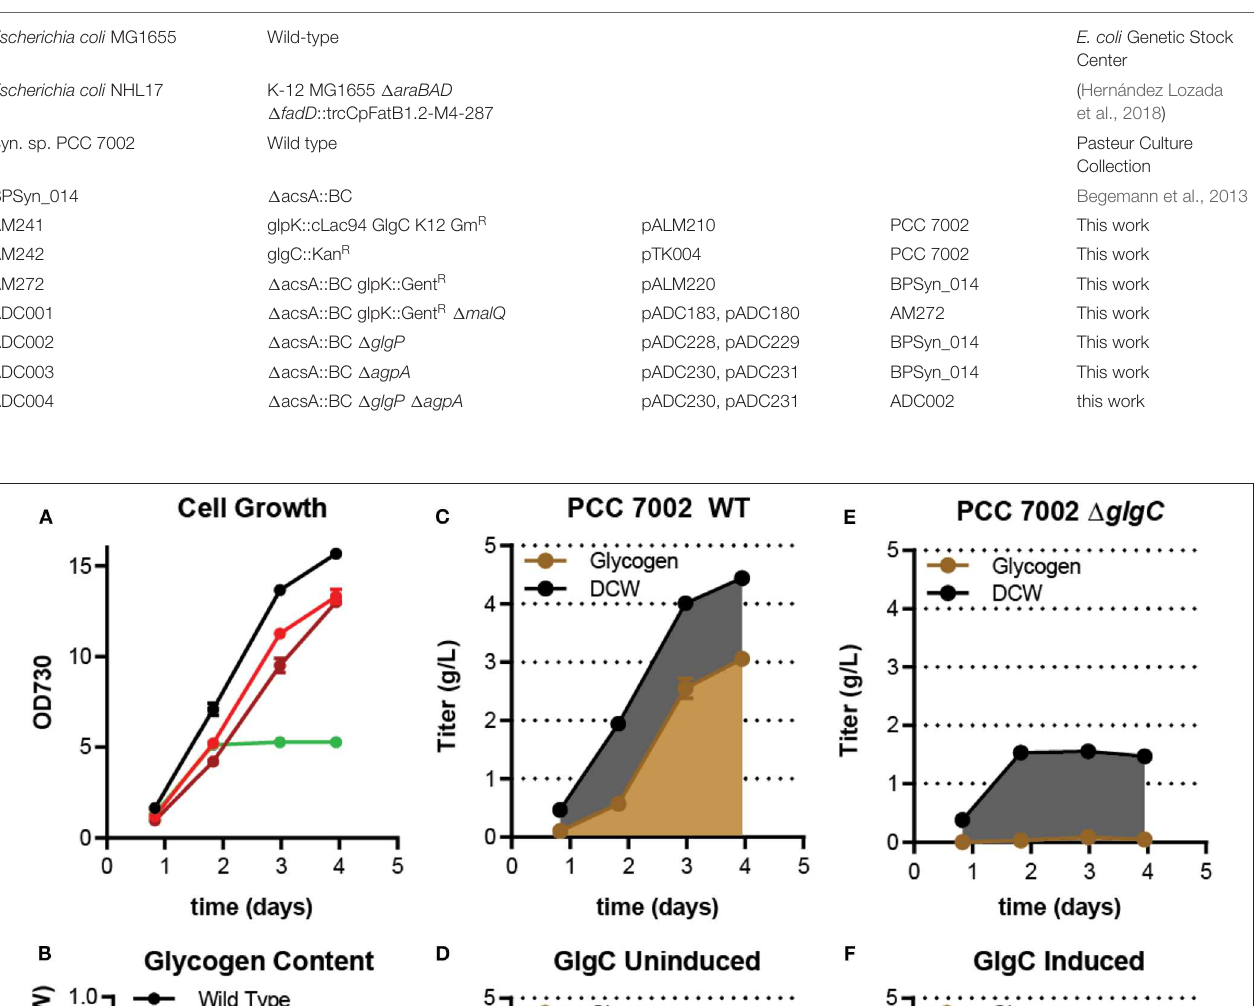
Frontiers in Energy Research |